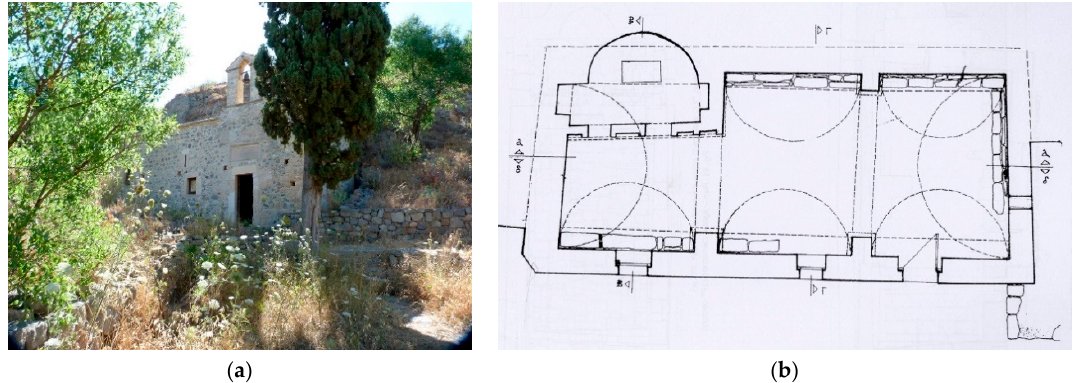
Figure 30. Church of Hagios Georgios Katholikos, Paliachora (Aegina), end of the 14th c. ( a ) View from the west © Author; ( b ) ground plan. Source: (Karachaliou 2012).